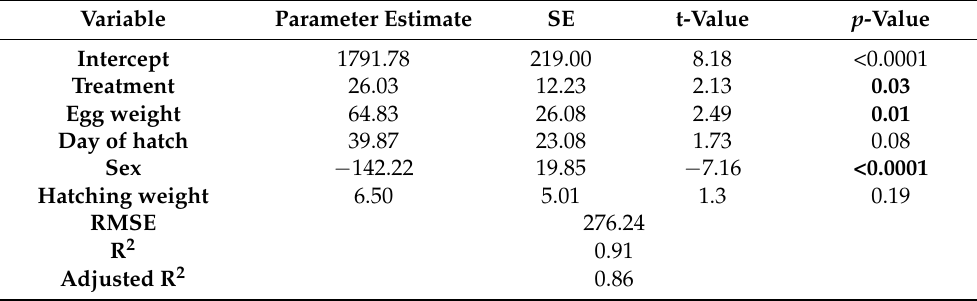
Table 7. Parameters of the multiple regression procedure to evaluate the main effects on the final body weight.